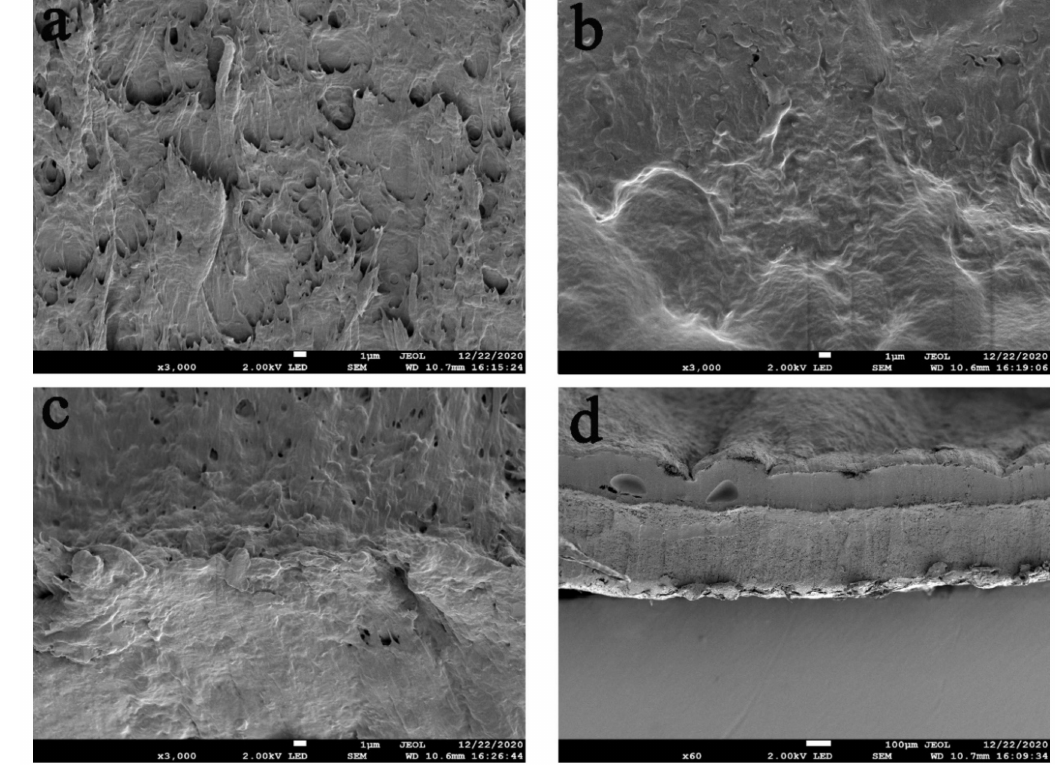
Figure 3. SEM images of ( a ) PVA, ( b ) PVA/CS (outer hydrogel), ( c ) PVA/Ag@MOF (inner hydrogel), and ( d ) Bilayer hydrogel.